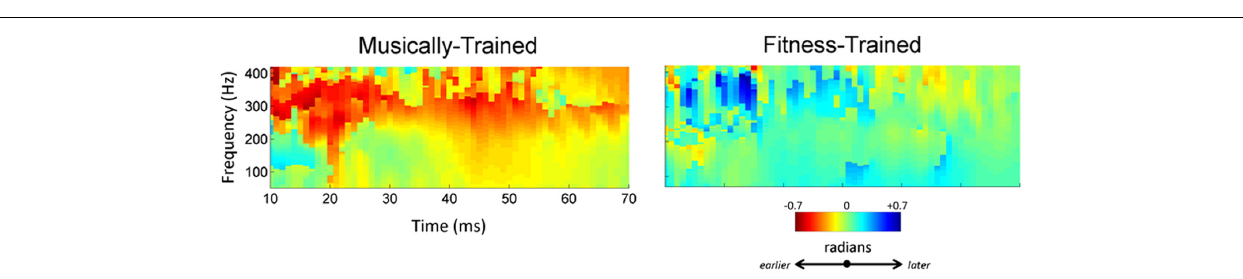
FIGURE 4 | High school music classes lead to earlier brain responses to speech. Following training, the music group (left) shows an earlier response as evidenced by a negative phase-shift within the 70–400 Hz range that appears as a band of red.The neural response of the fitness training group (right) was stable (green) from pre- to